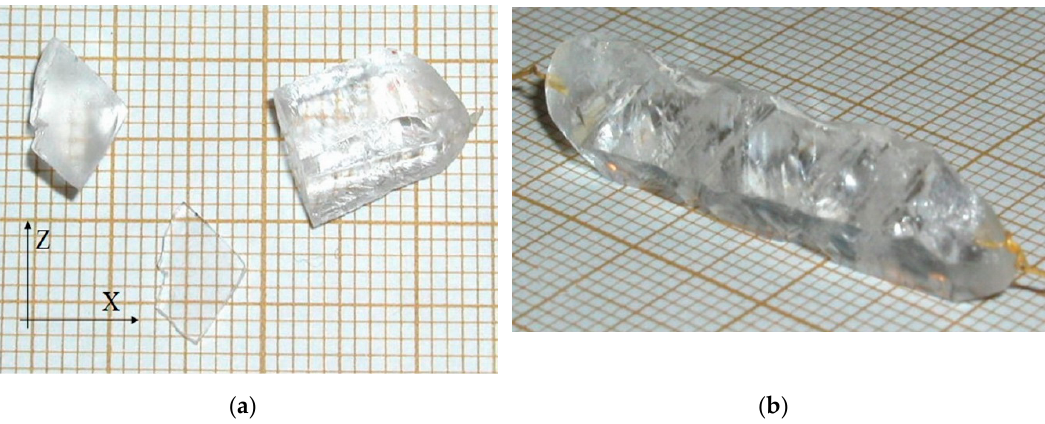
Figure 6. GaPO 4 crystals grown on x{1210} seeds, ( a ) plate cut perpendicular to Y axis, ( b ) typical habit of the crystals represented by appearance of the trigonal rhombohedral faces interrupting formation of negative and positive trigonal prism faces.